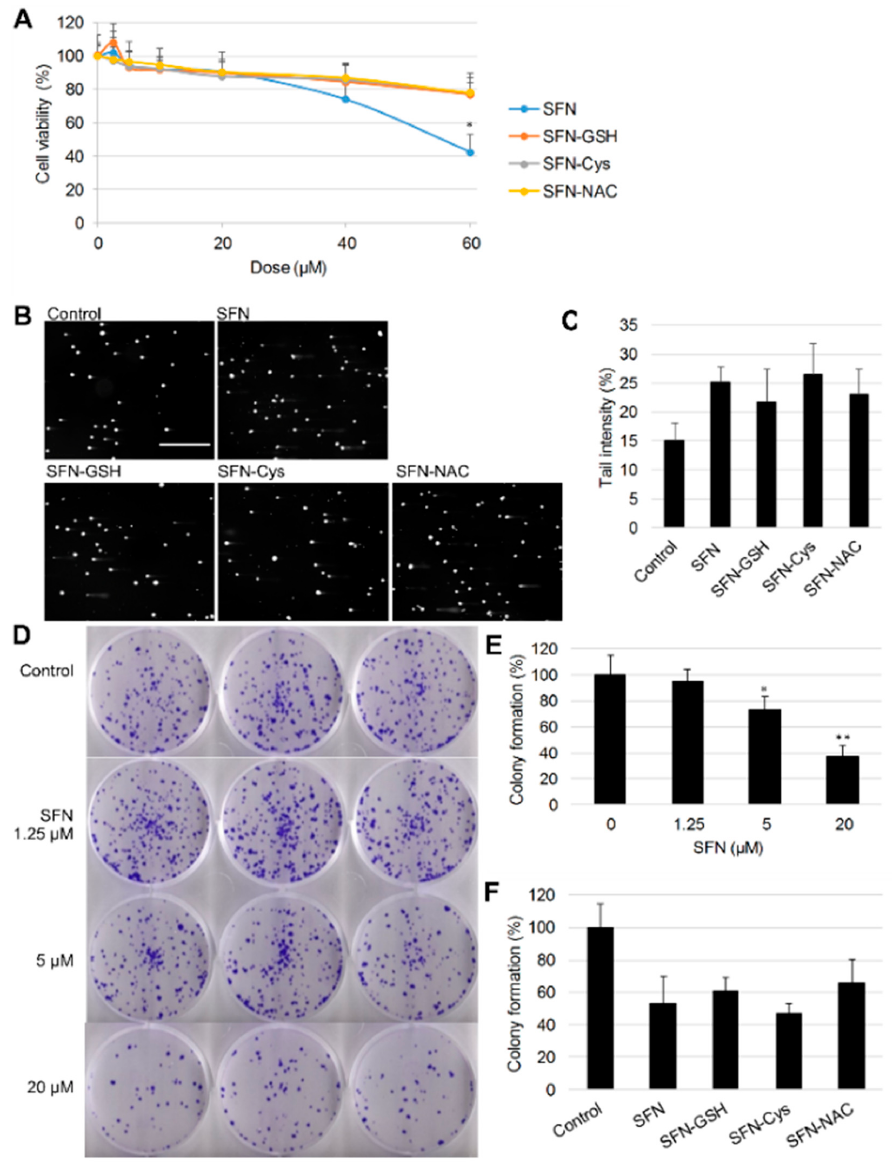
Figure 2. Effect of SFN and its metabolites on cell viability, genotoxicity and colony formation of HepG2 cells. ( A ) Cells were treated with different doses of SFN or its metabolites for 24 h, then cell viability was determined by the 3-(4,5-dimethylthiazol-2-yl)-2,5 diphenyl tetrazolium bromide (MTT) assay with dimethyl sulfoxide (DMSO) (0.1%) as control. Results represent the mean ± SD ( n ≥ 5). Statistical significance within groups treated with the same dose, * p < 0.05. ( B ) Cells were treated with 20 µM SFN or metabolites with DMSO (0.1%) as control for 24 h, then levels of DNA strand breaks were determined by alkaline comet assay. Representative pictures from the comet assay. Scale bar = 500 µm. ( C ) Tail intensity was measured for at least 100 comets per sample. Data are presented as means ± SD. ( D ) Cells were treated with 1.25, 5 and 20 µM SFN with DMSO (0.1%) as control for 24 h, then seeded into 6-well plates for colony formation. After 14 days of incubation, formed colonies were stained for photograph and quantified ( E ). Statistical significance from the control, * p < 0.05, ** p < 0.01. ( F ) Cells were treated with 10 µM SFN or metabolites with DMSO (0.1%) as control, followed by colony formation and quantification. Results represent the mean ± SD ( n = 3).